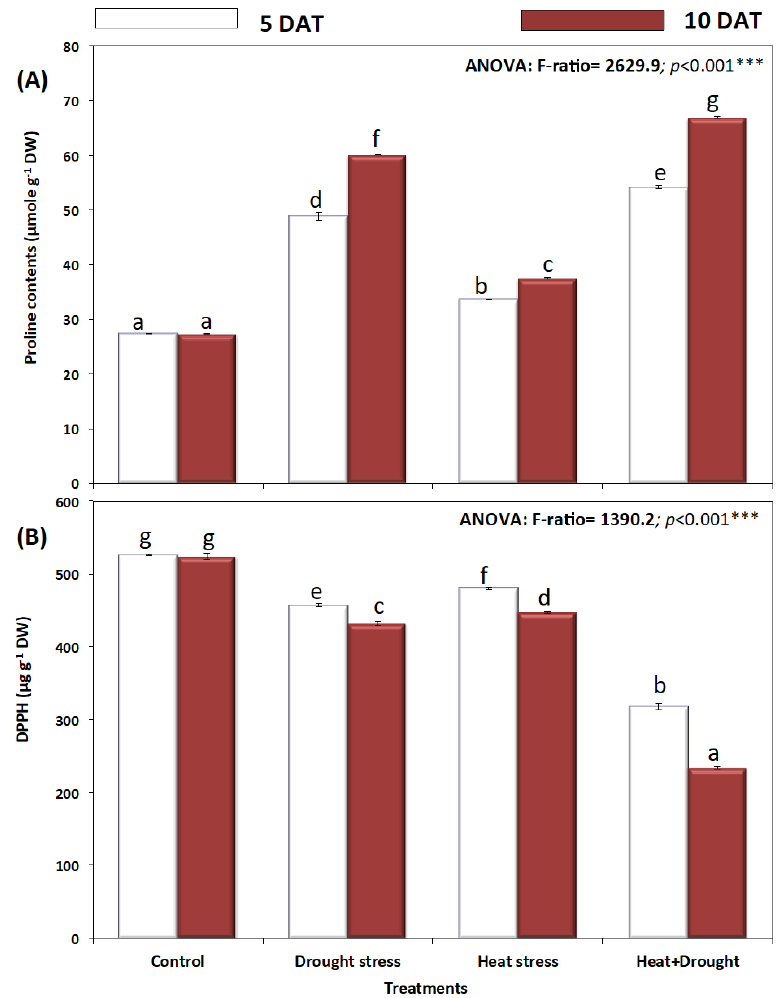
Figure 9. Effect of drought, heat, and interaction between drought and heat stresses on ( A ) proline content and ( B ) Total antioxidant estimated by DPPH free radical scavenging activity of A. sieberi alba. Data expressed as mean of triplicates, error bars represent standard error for means. Means marked with different letters are significantly different according to ANOVA and DMRTs at p < 0.05.